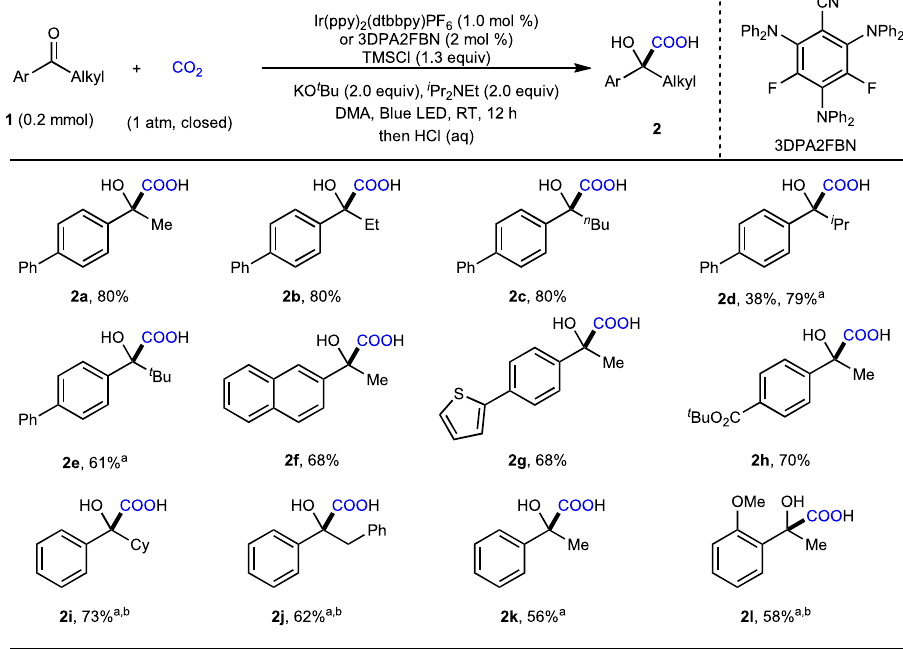
Fig. 4 Substrate scope of alkyl aryl ketones. The standard conditions were used, as shown in Fig. 3, entry 7. Isolated yields of corresponding carboxylic acids 2 are shown. a Using 3DPA2FBN (2.0 mol %) instead of Ir(ppy) 2 (dtbbpy)PF 6 . b KO t Bu (2.5 equiv), DMA (4